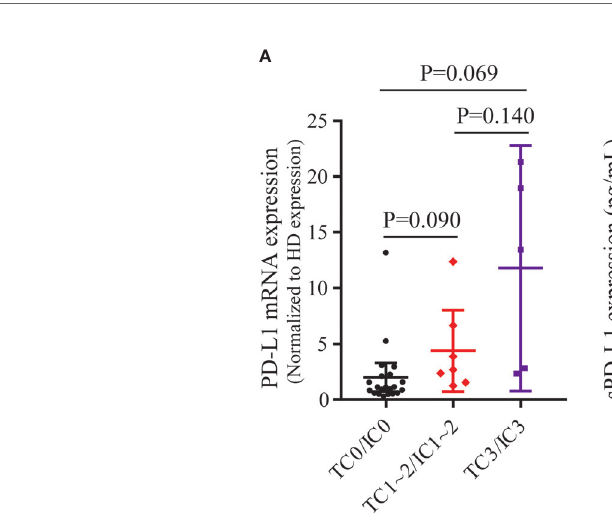
FIGURE 1 | The correlation of tPD-L1 and bPD-L1 in 33 NSCLC patients. (A) The correlation of PD-L1 mRNA and tPD-L1. (B) The correlation of sPD-L1 and tPD-L1. tPD-L1, tissue PD-L1; bPD-L1, blood PD-L1; sPD-L1, soluble PD-L1; NSCLC, non-small-cell lung cancer. P values were calculated by independent-samples